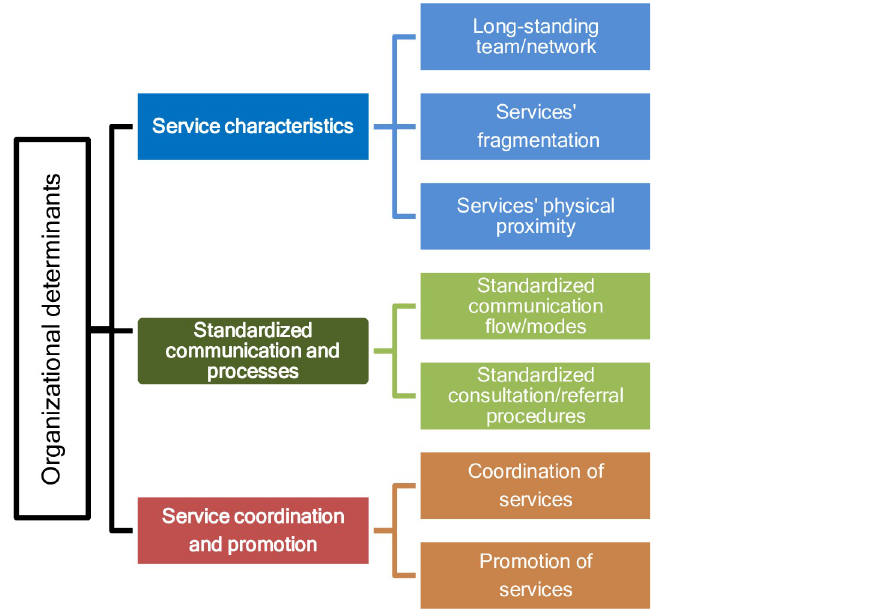
Fig 2. Themes summarizing organizational determinants to collaboration.